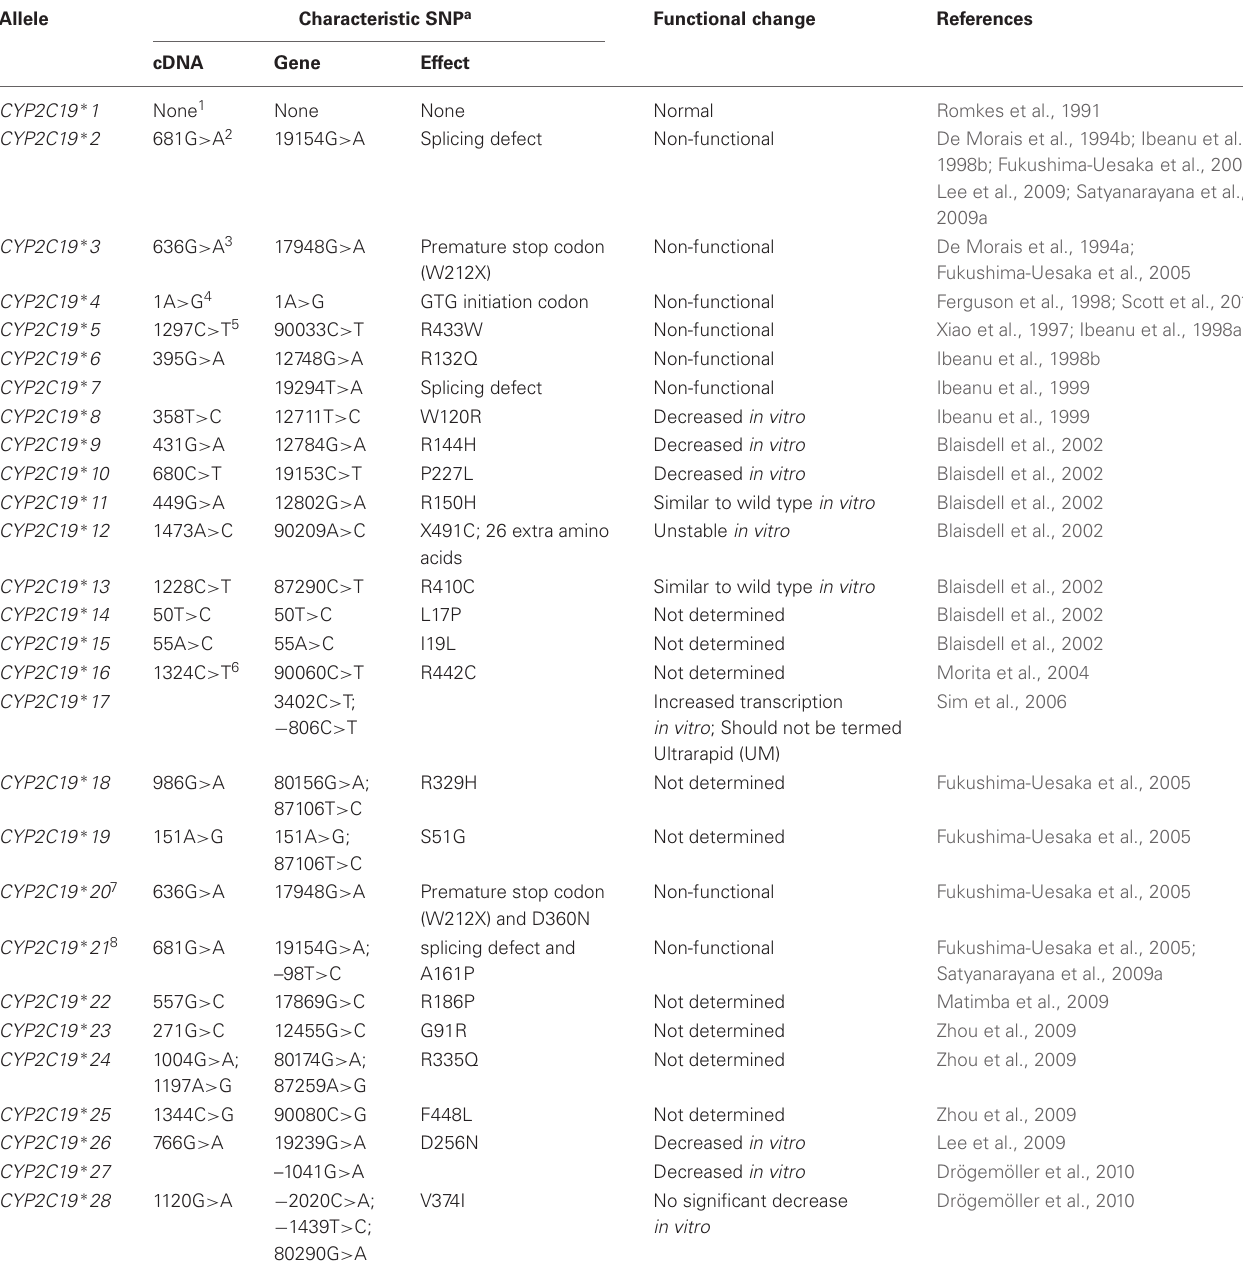
Table 1 | CYP2C19 gene